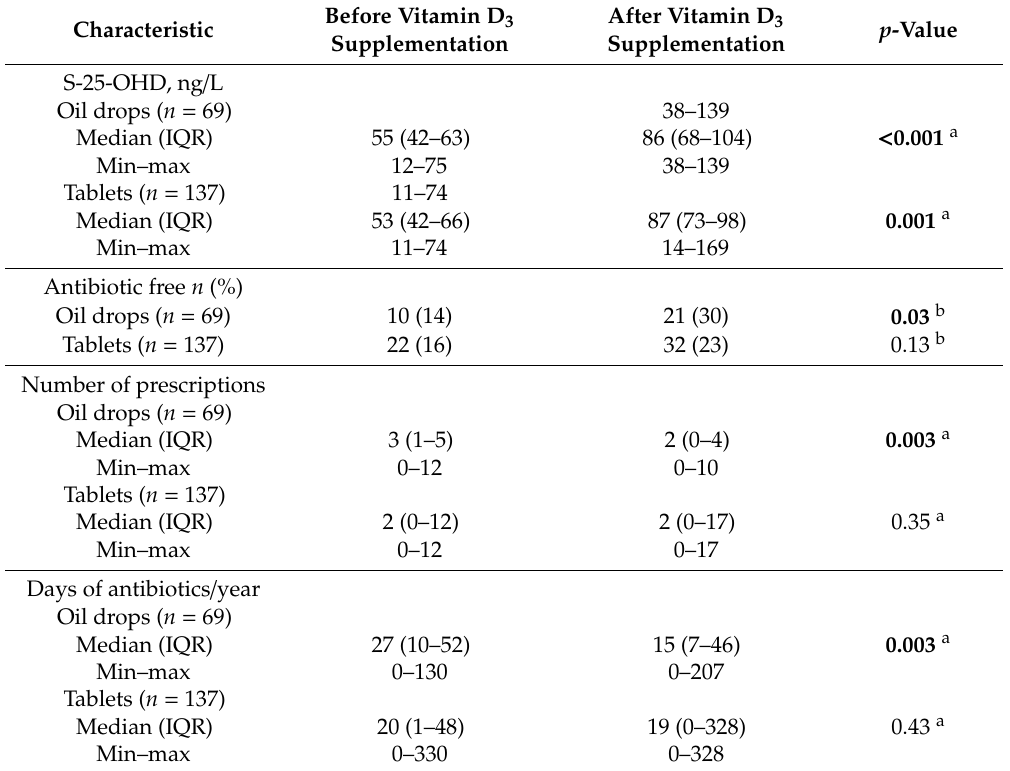
Table 2. Outcome for S-25-hydroxyvitamin D (S-25-OHD) concentrations after 3 months and antibiotic consumption after 12 months in immunodeficient patients receiving vitamin D 3 supplementation as oil drops (1500 IE / day) or as tablets (1600 IE / day) for one